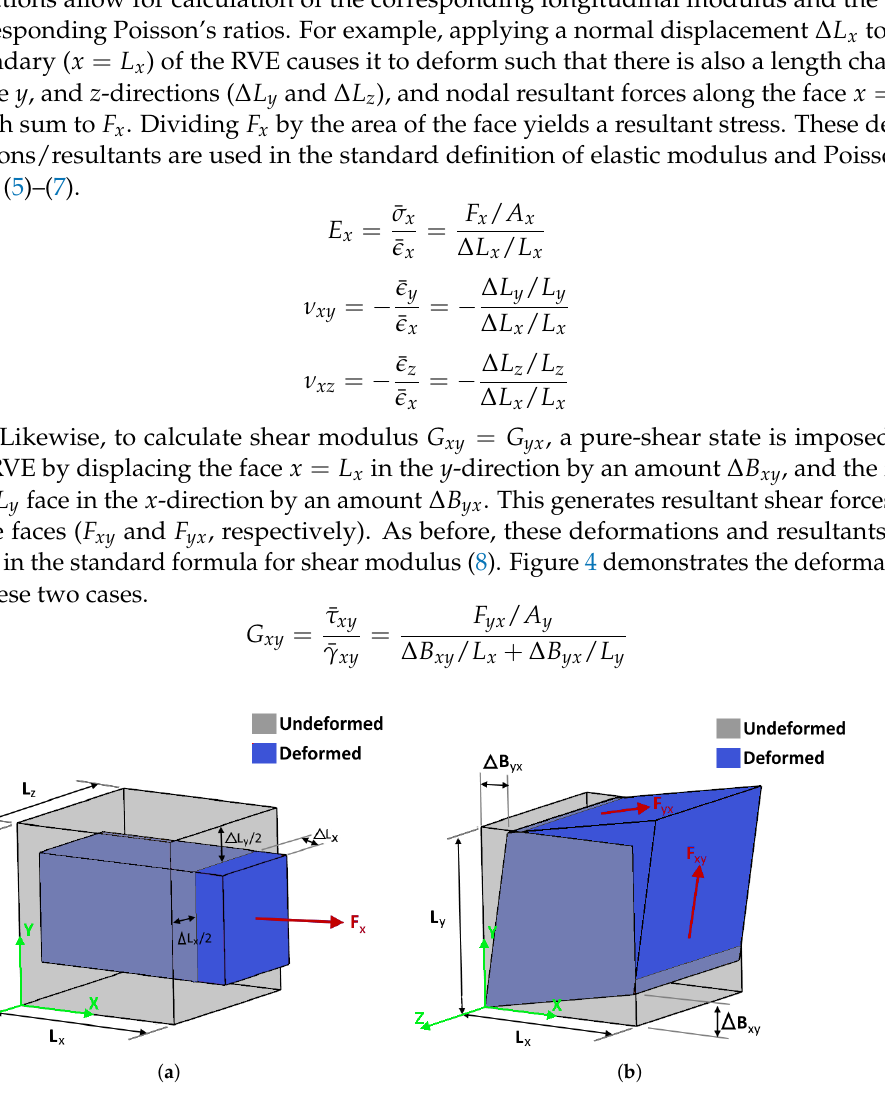
Figure 4. Examples deformations of the gyroid representative volume element (RVE) (adapted from [40]). ( a ) RVE with applied longitudinal strain; ( b ) RVE with applied shear